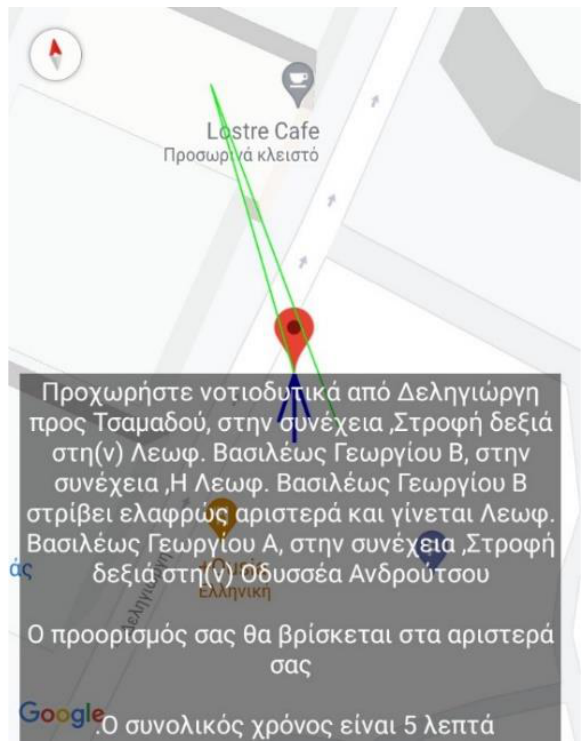
Figure 2. Navigation with great accuracy —text in figure: “Head southwest on Deligiorgi toward Tsamadou. Next, turn right onto Leoforos Vasileos Georgiou B. Next, slight left onto Leoforos Vasileos Georgiou A. Next, turn right onto Odissea Androutsou. Your destination will be on your left. Overall estimated time is 5 min”.